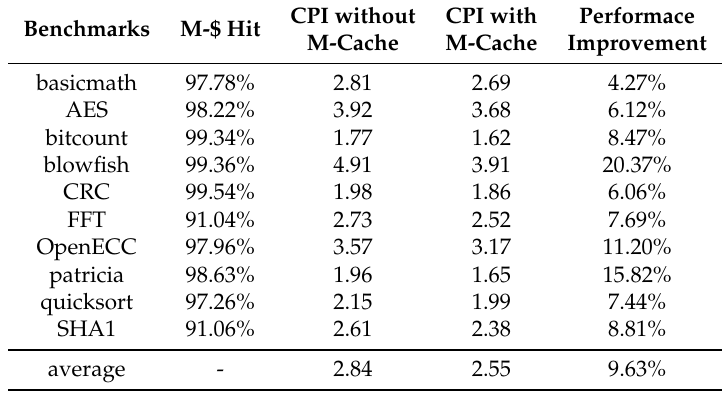
Table 7. Performance improvement of processor configured with